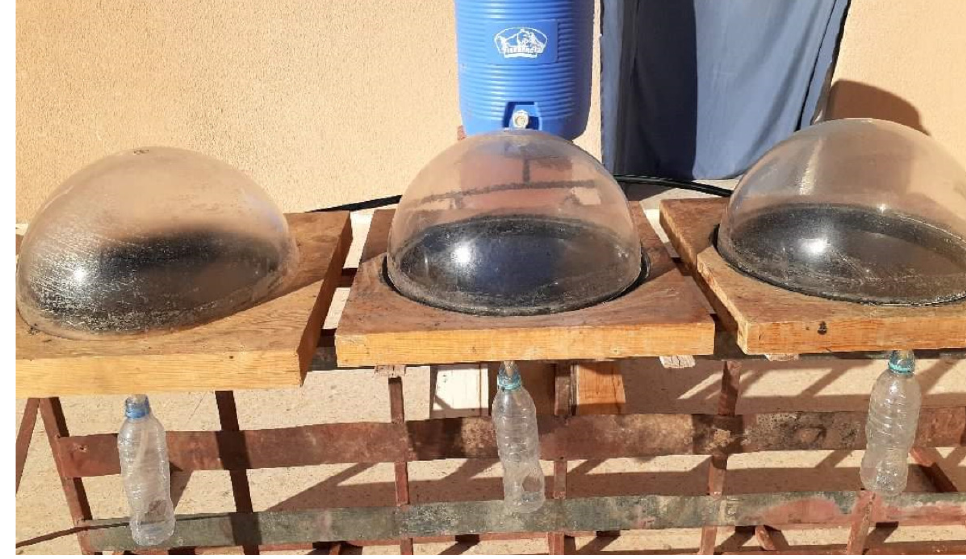
Figure 4. Graphical representation of the different configurations of hemispherical solar still.